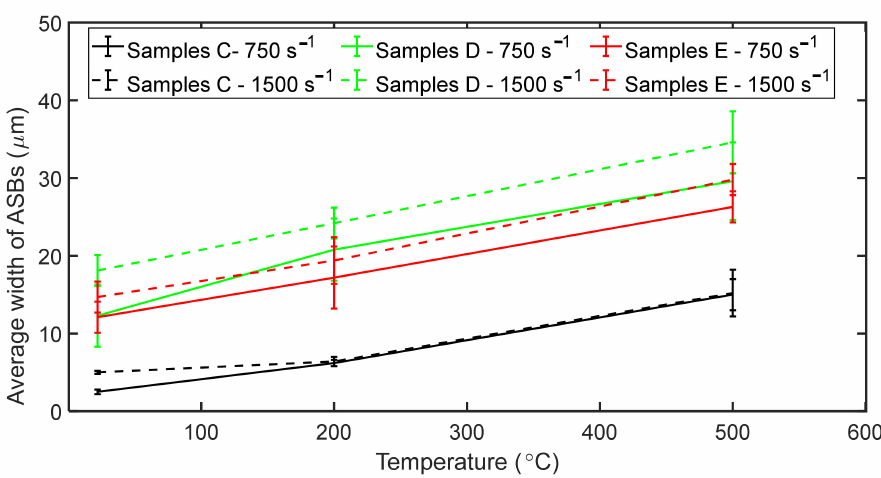
Figure 17. Variation of the average width of adiabatic shear bands as a function of temperature and strain rate for samples C, D and